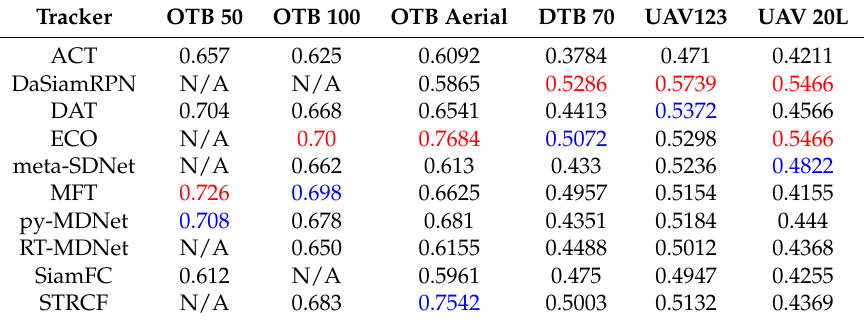
Figure 8. Precision plots of OPE of the UAV123 dataset attributes. DaSiamRPN outperforms the other trackers in most of the challenges where DAT outperforms other trackers in BC, FOC, IV, LR, and SOB challenges. Best viewed in color. Table 3. Comparison of AUC tracker performance for various datasets. Scores show that trackers perform worse in aerial datasets compared to the ground based datasets. Red indicates top performance and blue indicates runner up. Best viewed in